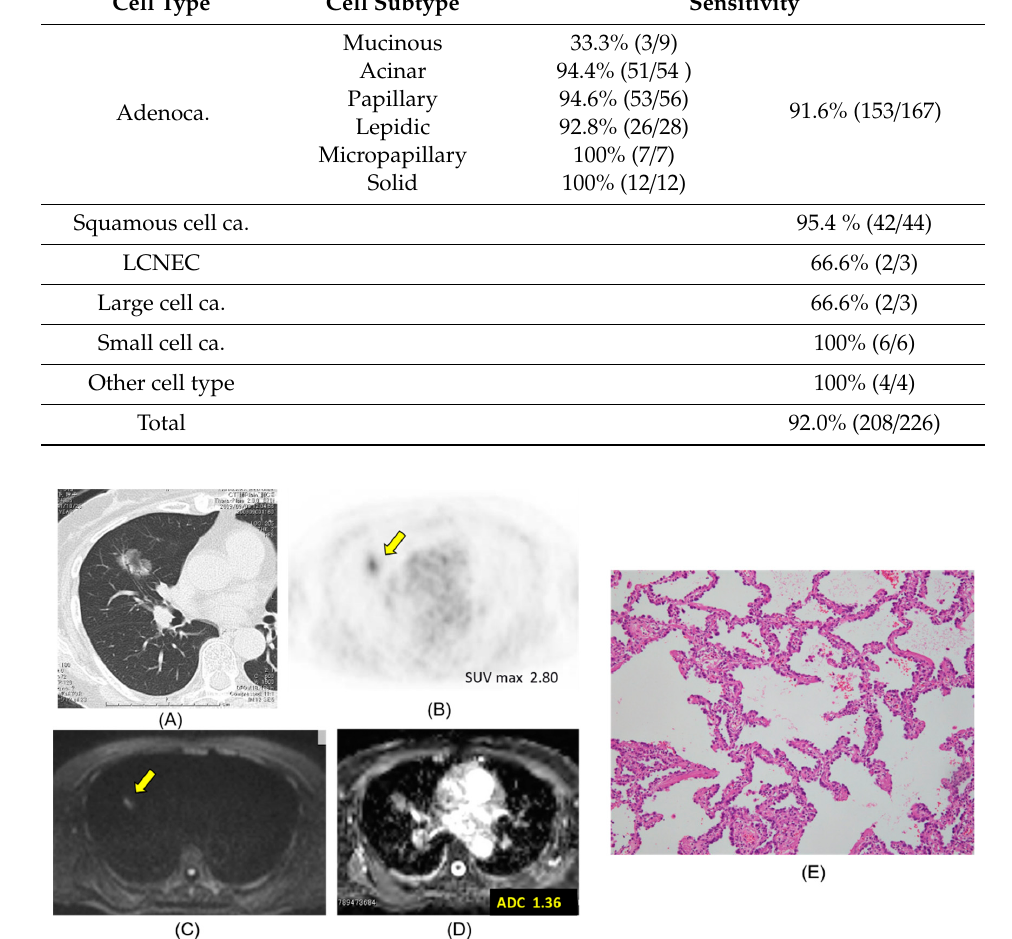
Figure 1. Lepidic adenocarcinoma. The ADC of the carcinoma was 1.36 × 10 − 3 mm 2 / s. ( A ) CT, ( B ) PET-CT, ( C ) DWI, ( D ) ADC map, ( E ) Pathology (Hematoxylin and Eosin Staining) × 100.